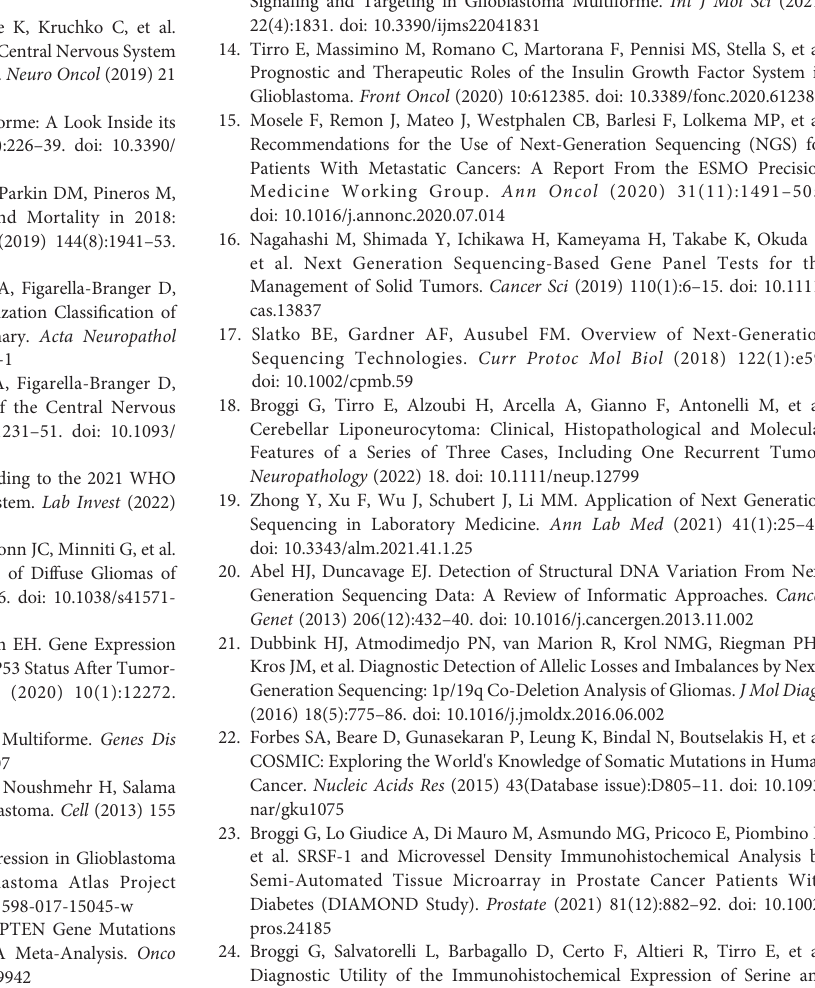
Supplementary Figure 2 | Detection of mutant H3-3A and TP53 by immunohistochemistry and NGS. (A) Strong and diffuse nuclear immunoreactivity for H3.3K27M (immunoperoxidase; original magni fi cation 200x) (left panel) and corresponding H3-3A c.83A>T (p. K27M) mutation detected by NGS (right panel) in the case of a diffuse midline glioma. Results were viewed in the IGV. (B) Strong and diffuse nuclear expression of p53 in a TP53 -mutant glioma (immunoperoxidase; original magni fi cation 200x) (left panel) and corresponding TP53 c.659A>G (p. Y220C) mutation detected by NGS (right panel) in a case of GBM. Results were viewed in the IGV. (C) Focal nuclear immunoreactivity for p53 in a TP53 wild-type glioma (immunoperoxidase; original magni fi cation 200x). Note that TP53 is a negative- sense gene relative to the genomic reference sequence. Hence, a nucleotide change is displayed as a reverse complement.